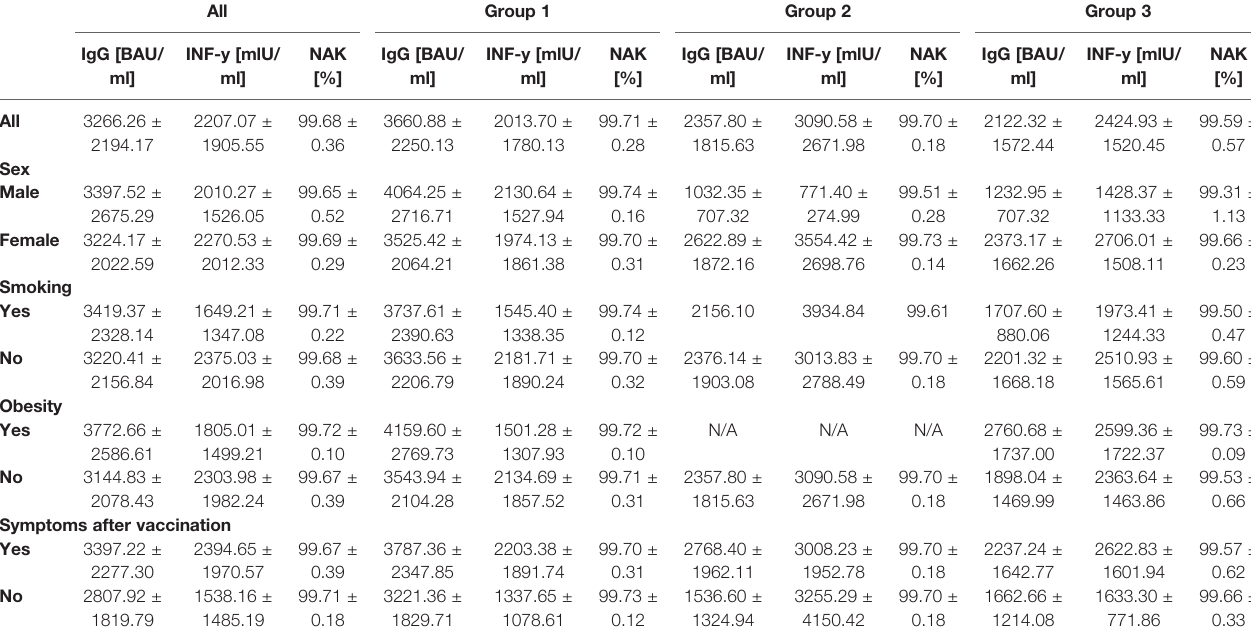
TABLE 2 | Values in accordance to the immunization protocol.